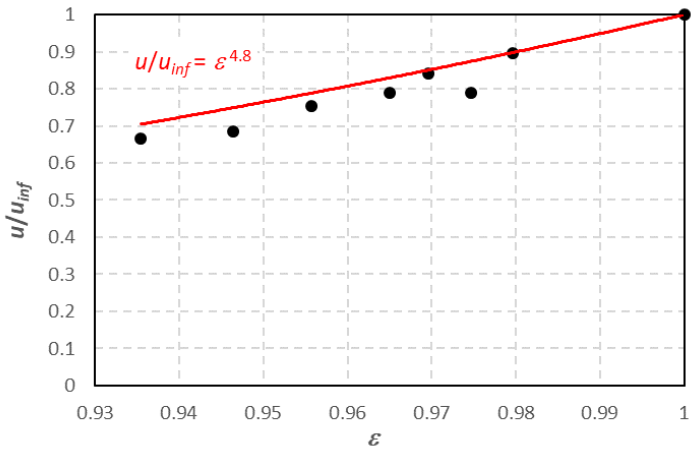
Figure 4. Hindered settling of monodisperse spherical particles in the Stokes regime in dependence on the porosity of the suspension cloud (points indicate experimental results; solid line indicates exponent in Equation (2) according to [13]).